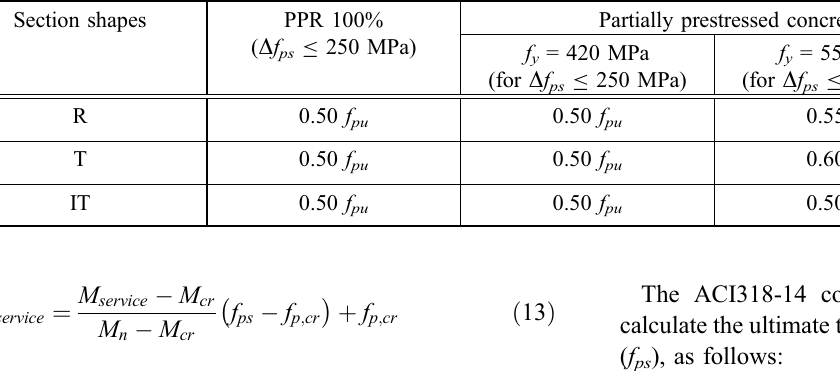
Table 3 Minimum effective prestress ( f se ,min ) to satisfy the tensile stress limit ( D f ps , allow ). Section